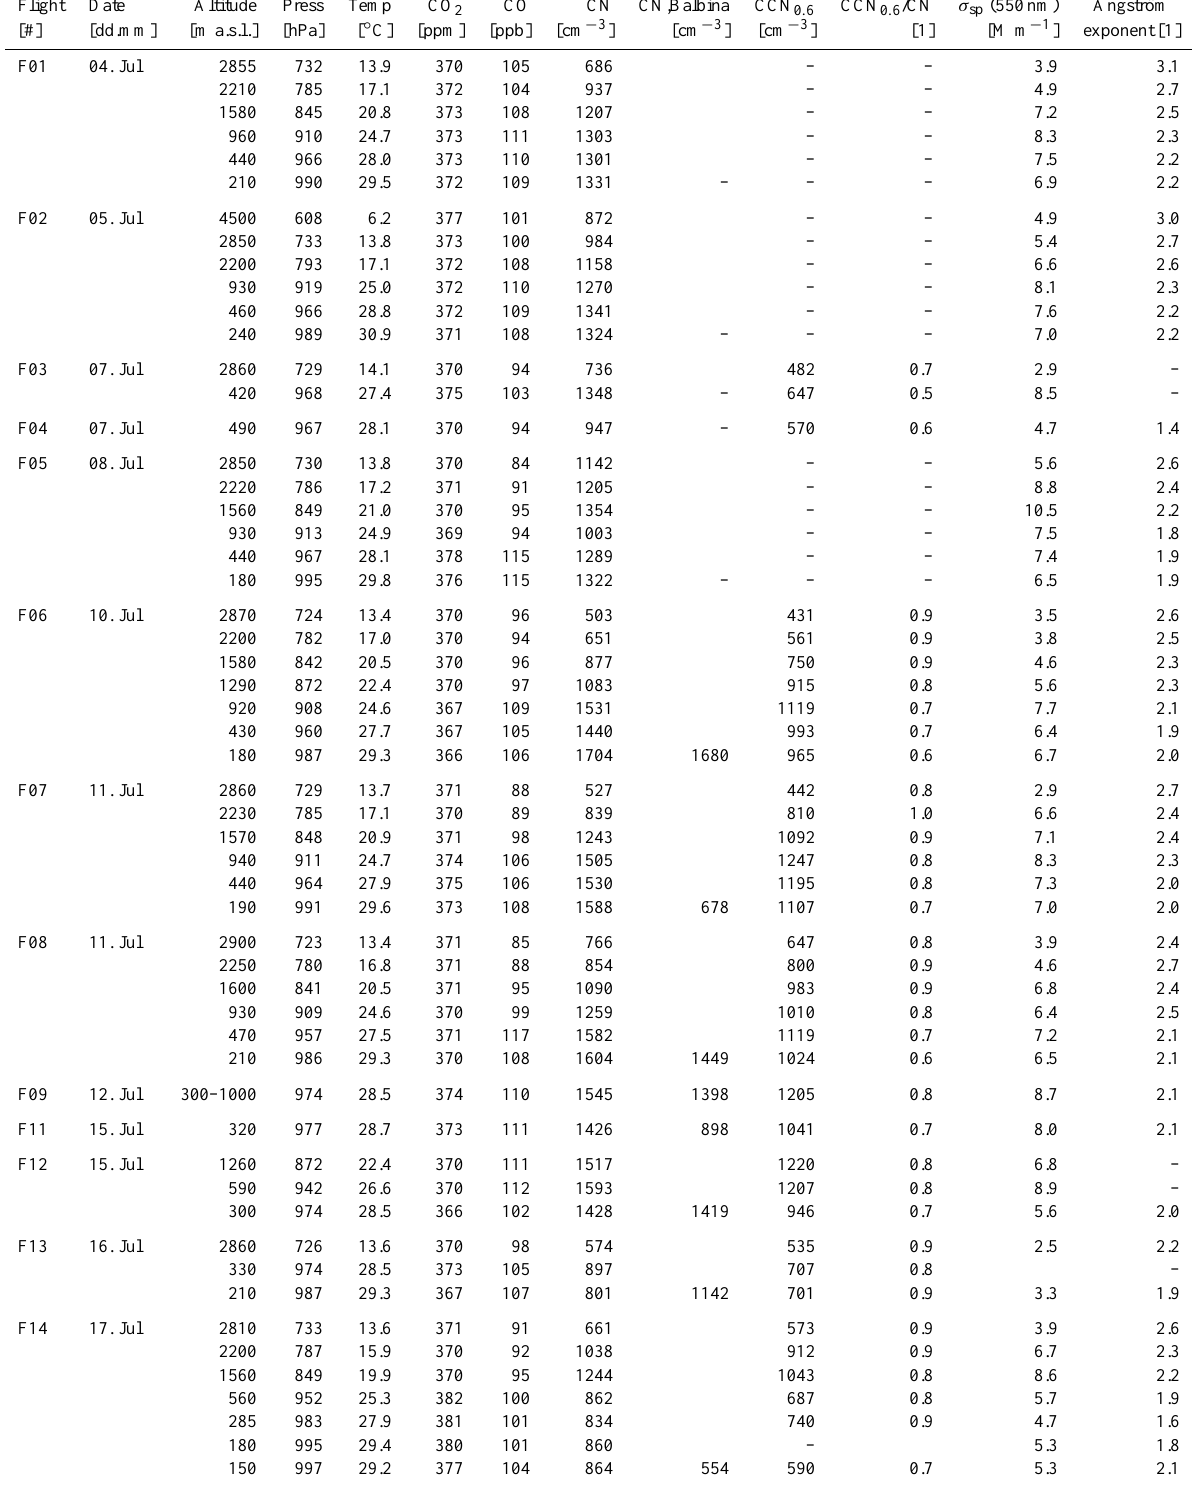
Table 1. Complete set of measurements of long-lived trace gases and aerosols in the regional background atmosphere (outside the Manaus urban plume and occasional regional biomass smoke plumes) during LBA-CLAIRE-2001. CN Balbina refers to CN concentrations measured simultaneously at the Balbina ground-based site. σ sp (550nm) is the scattering coefficient at 550nm wavelength. All concentrations and scattering coefficients have been normalized to standard conditions in dry air (273.15K,